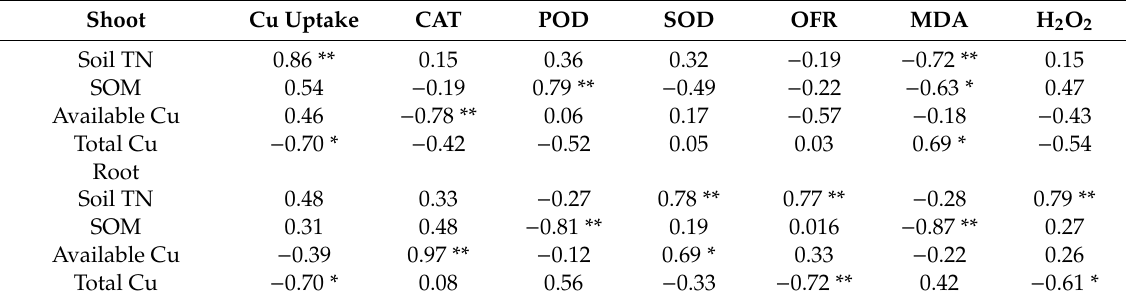
Table 7. Correlation analysis between properties of soil and